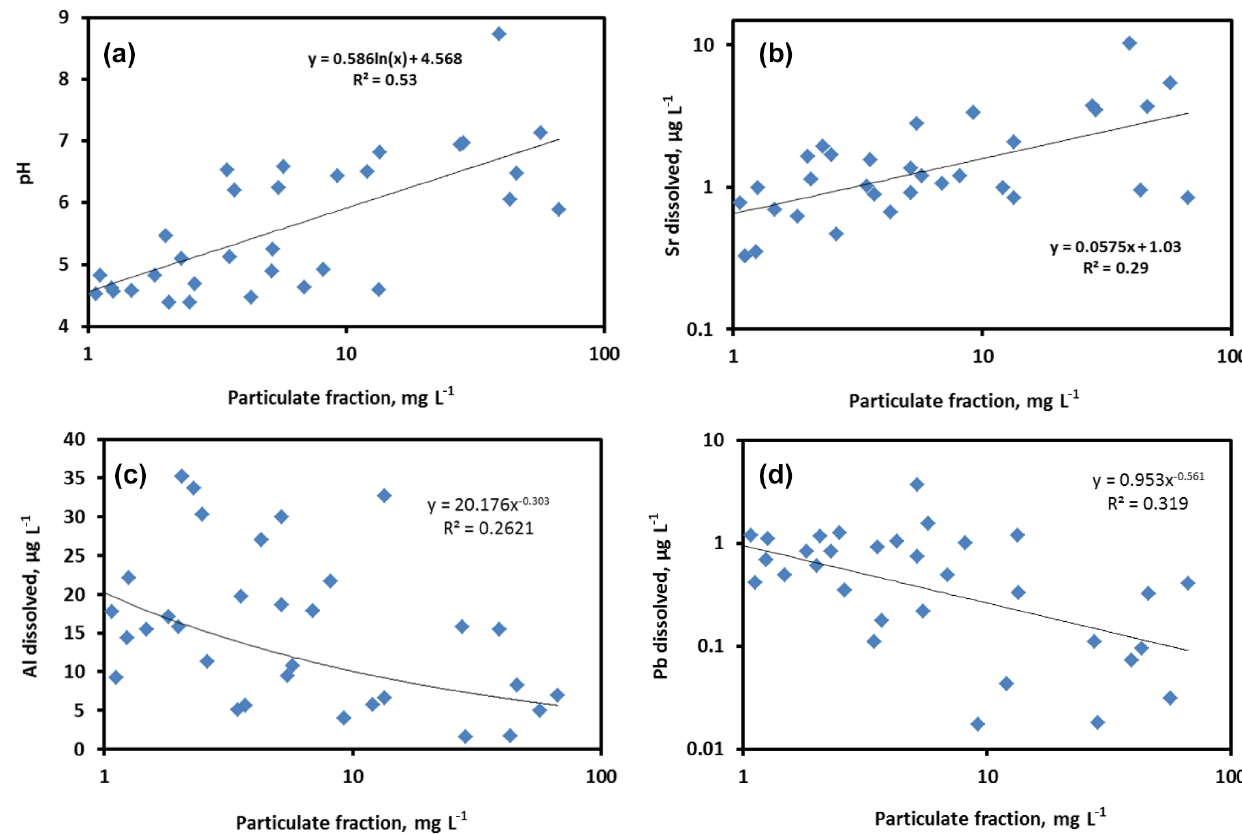
Figure 4. pH value (a) and Sr (b) , Al (c) and Pb (d) concentration in dissolved fraction of snow as a function of concentration of particles. Note log X scale for Sr and